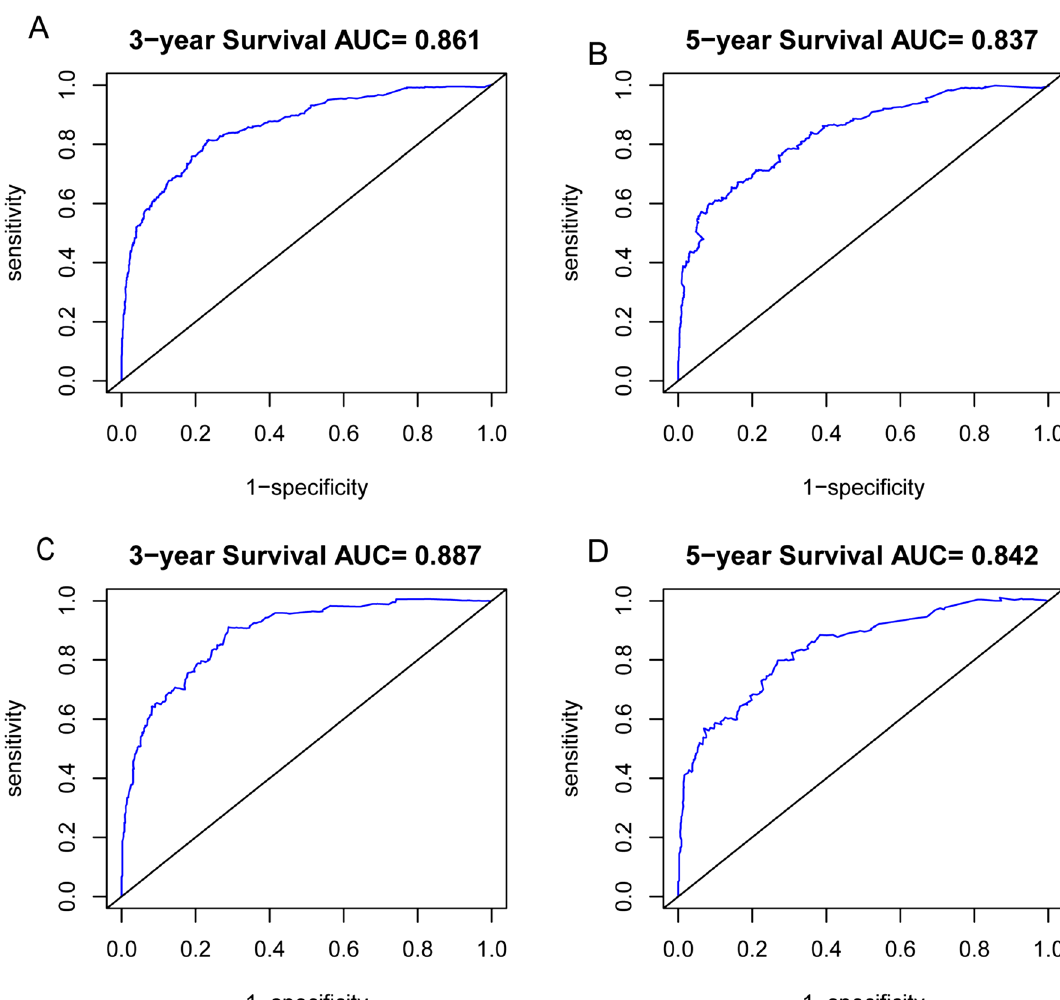
Figure 5. Receiver operating characteristic (ROC) analysis to assess 3-year ( A ) and 5-year ( B ) survival for second primary malignancy (SPM) patients in the training set; The ROC curve to assess 3-year ( C ) and 5-year ( D ) survival in the validation